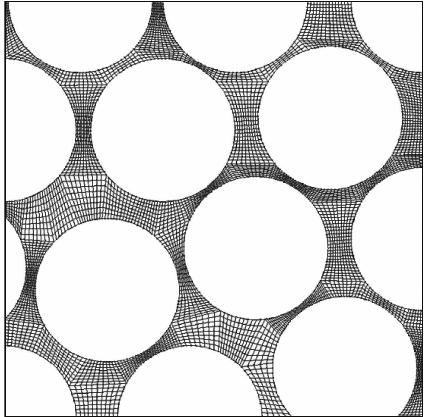
Figure 6: Two-dimensional model of the bundle with eight fibers randomly distributed.